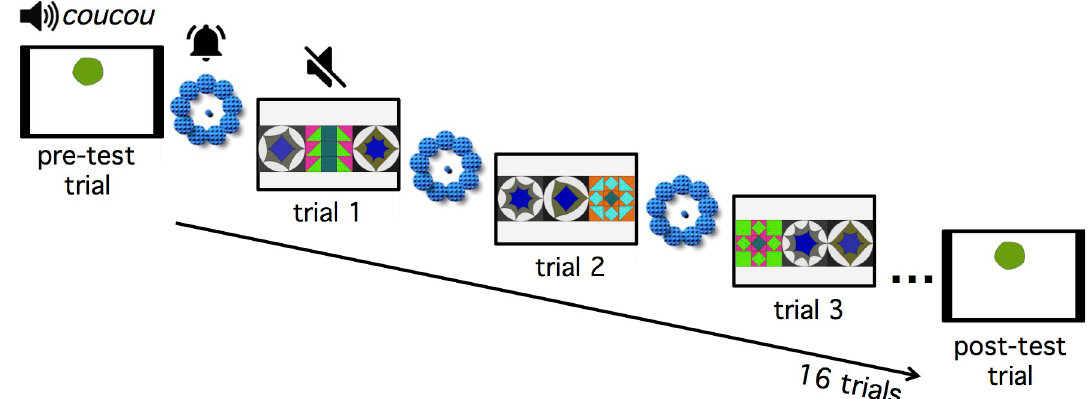
Fig 2. Procedure of the test. The study started with a pre-test trial in order to engage infants’ attention. Infants then saw a total of 8 structurally symmetrical and 8 structurally asymmetrical sequences, which were intermixed and preceded by an attention getter. A post-test trial identical to the pre-test trial ended the